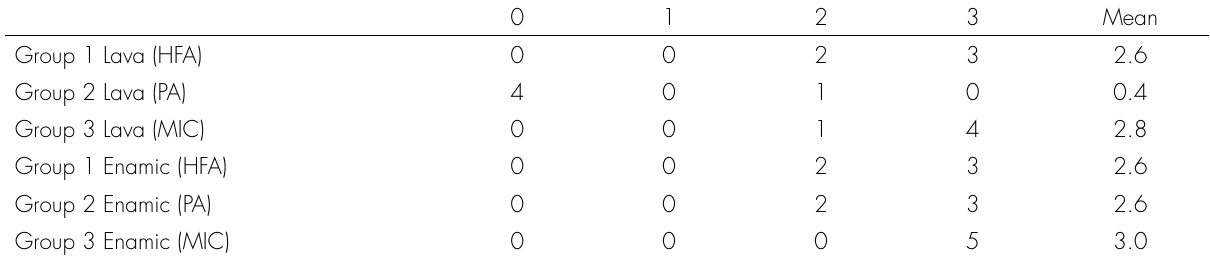
Table IV. Adhesive Remnant Index (ARI)